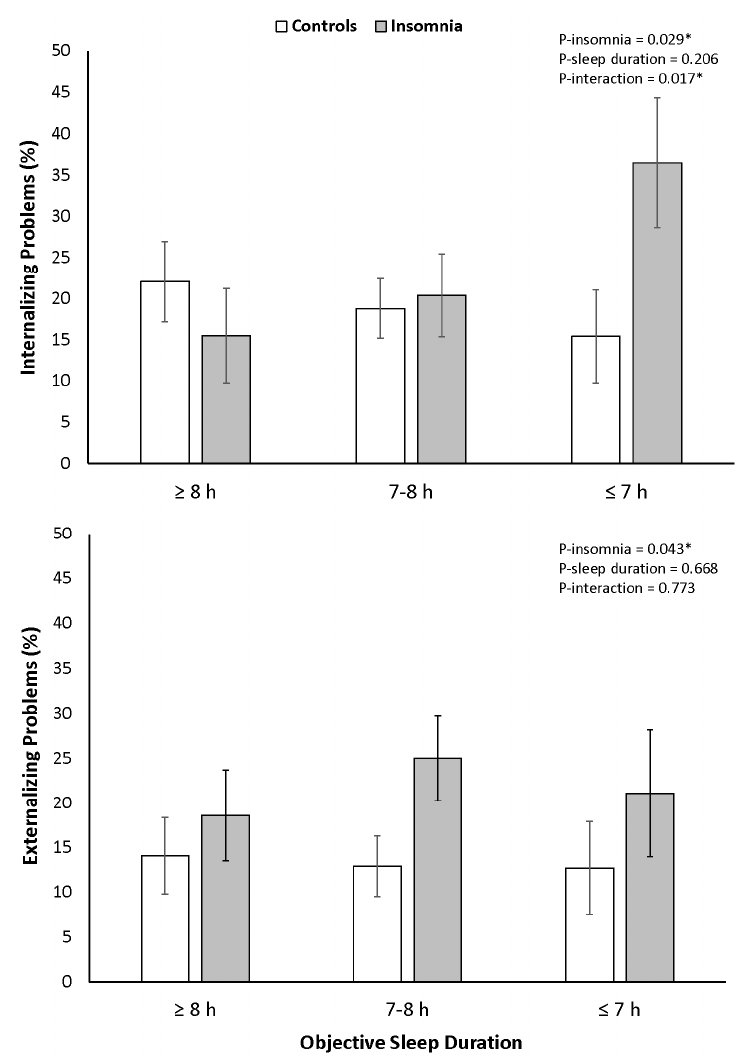
Figure 1. Clinically elevated internalizing and externalizing problems associated with insomnia symptoms across objective sleep duration groups. A significant interaction revealed that the association of insomnia symptoms with internalizing problems was primarily present in those with objective “short” sleep duration (i.e., ≤ 7 h), while insomnia symptoms among those with “normal” sleep duration (i.e., >7 h) was not significantly associated with internalizing problems. There was no significant interaction on externalizing problems but a significant main effect of insomnia symptoms. All data adjusted for sex, age, race, socioeconomic status, body mass index percentile, morning-eveningness questionnaire score, apnea/hypopnea index and periodic limb movement index.